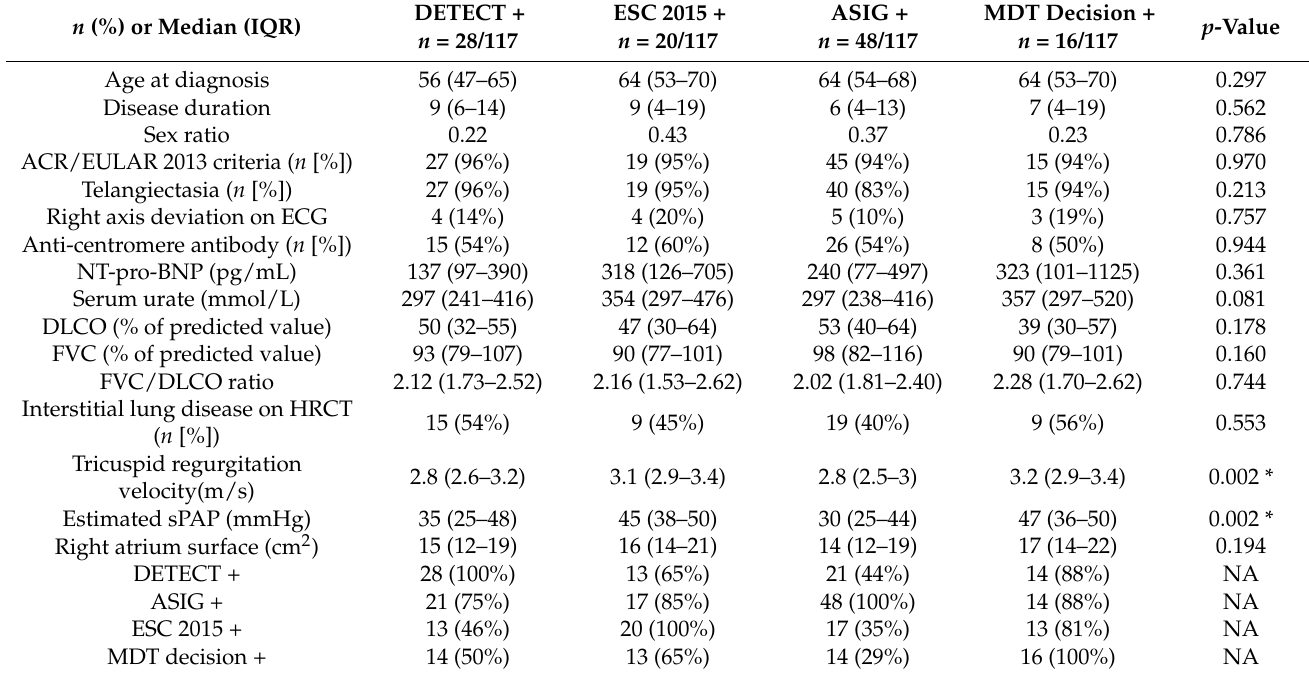
Table 2. Population characteristics according to the results of algorithms at